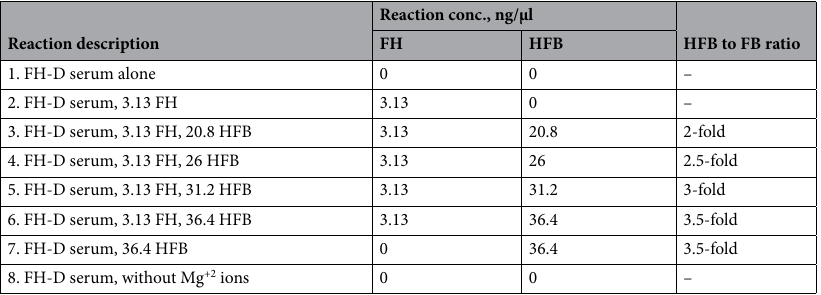
Table 3. FH and HFB concentrations in FH-D serum reactions. Protein concentrations of FH and HFB in reactions containing FH-D serum, low FH and increasing amounts of HFB. In reactions, the FH-D serum was diluted in 0.1 mM EDTA to produce final concentrations of 60 ng/µl C3 and 10.4 ng/µl FB. The FH concentration was equivalent to 12.5% of normal serum levels. C3a and Ba levels were measured after 5 min at 22 °C. The results are in Fig. 3. The values in the Reaction description are protein concentrations in